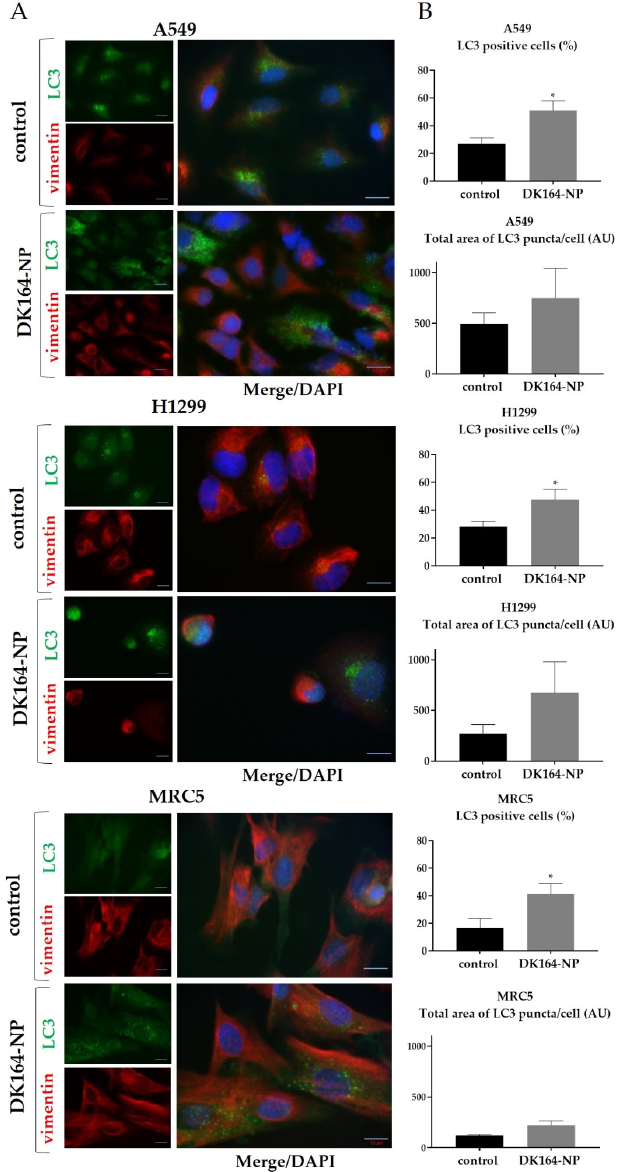
Figure 6. ( A ) Representative immunofluorescence images of the morphology of LC3-positive struc- tures (green), vimentin staining (red), and DAPI-staining (blue) in A549, H1299, and MRC5 control cells and cells, treated with the calculated IC50 concentration of DK164-NP for 24 h; ( B ) Quantification of the LC3 positive cells and the LC3 average total area per cell from the images in A performed using ImageJ quantification tool (* p < 0.05). Quantification was performed from three experiments with >75 cells quantified for each condition. Error bars represent standard deviation (SD); AU: arbi- trary units. Scale bars represent a distance of 15 µm.